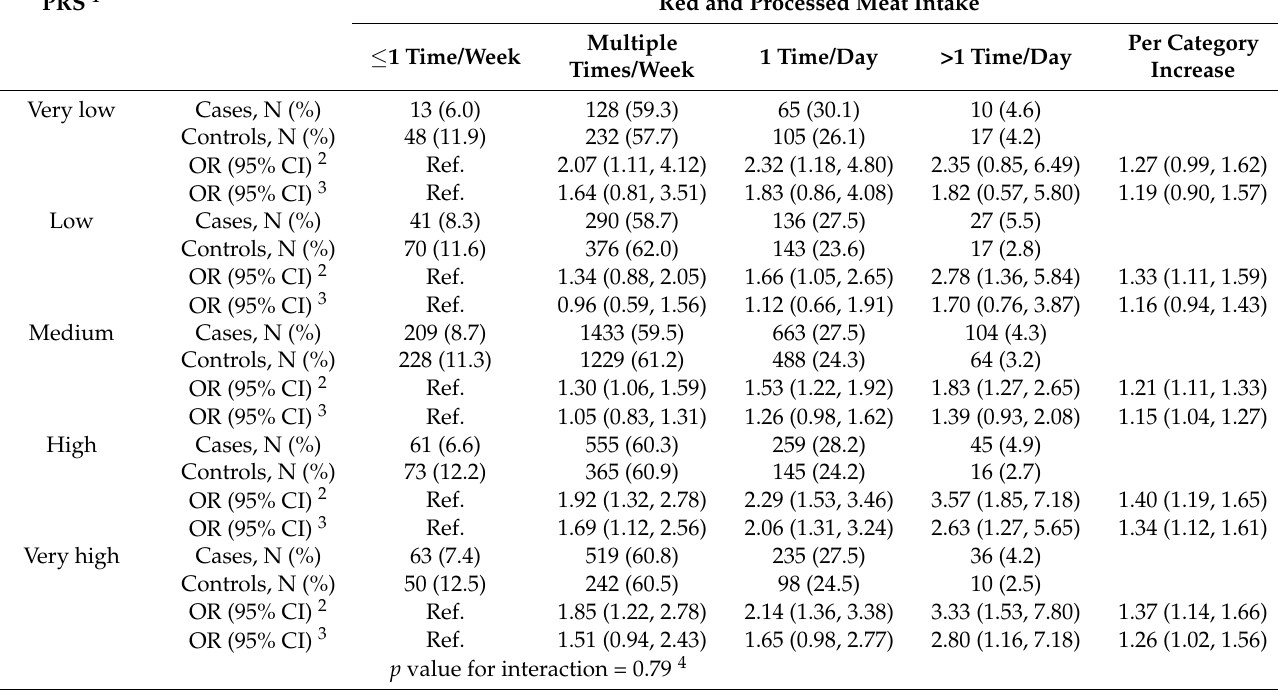
Table 3. Association of red and processed meat intake with colorectal cancer risk by polygenic risk score.